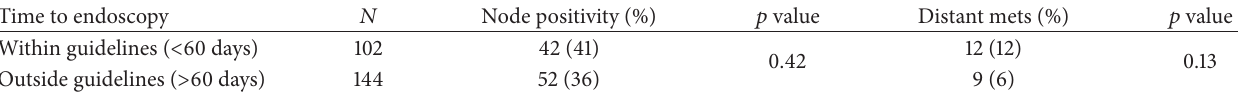
Table3:Effectofendoscopywait-timeoncancerstage.Theresultsofananalysisoftheeffectofwait-timefromreceiptofreferraltoendoscopy